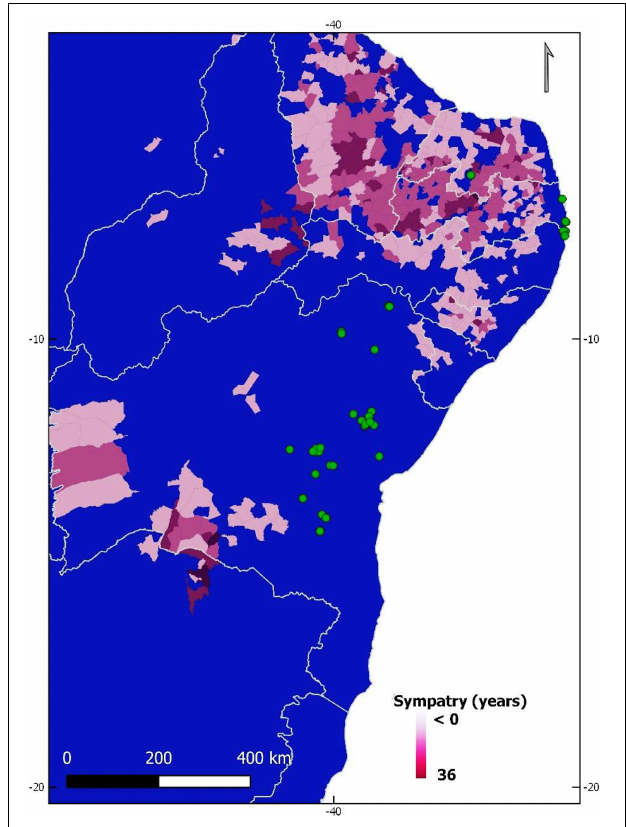
FIGURE 4 | Number of years with cotton planted in more than 5% of the municipality area in an interval of 36 years (1974–2019), indicating the possibility of sympatry among Gossypium mustelinum and cultivated